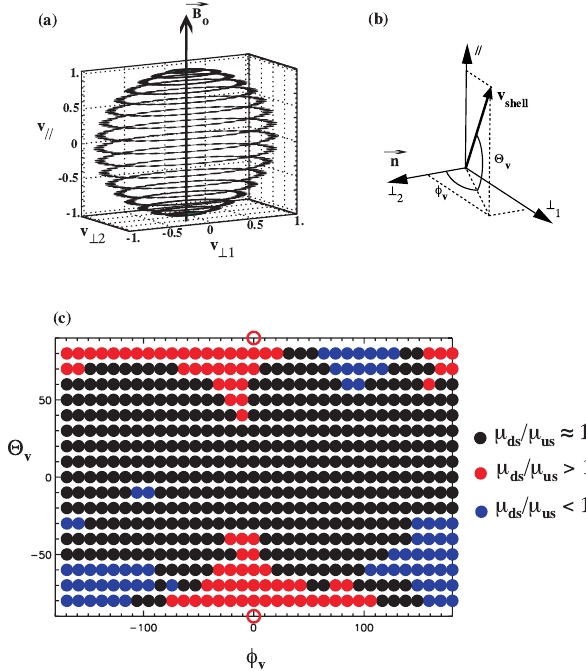
Fig. 6. Sketch of the electron trajectory (in the reference frame mov- ing with the particle) when the particles hit the shock front (injec- tion time) for the nonadiabatic behavior. All nonadiabatic particles with a perpendicular gyrating velocity (velocity v 1 and v 2 ) in the left part of the plot (blue frame) will suffer a “under-adiabatic” be- havior from the electrostatic field present in the ramp. Conversely, the particles (velocity v 3 and v 4 ) in the right part of the plot (red frame) will be “over-adiabatic” under the action of the shock ramp electrostatic field. The green arrow represents the direction of the supercritical shock propagation. At the bottom, an enlarged view of the velocity space (several electron gyroperiods τ ce ) is plotted before and after the particle hits the shock ramp. The gyromotion around the injection time (i.e. in the upstream region just before the electron enters the ramp) and the first full gyration performed within the ramp are indicated, respectively, by a thick orange line and a thick dotted blue line.